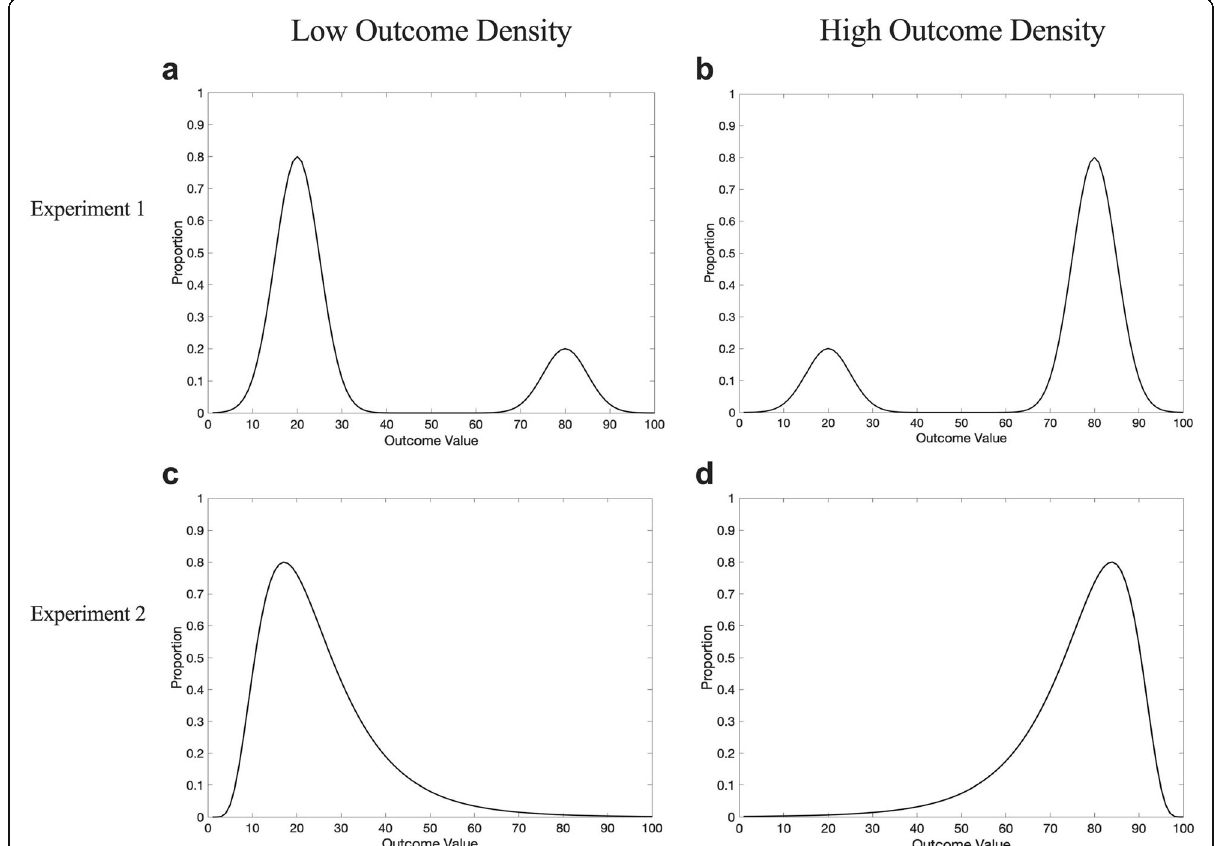
Fig. 1 a Bimodal outcome distribution presented to participants in variable outcome and low OD condition, where 80% of outcomes were low in magnitude. b Bimodal outcome distribution presented to participants in the variable outcome and high OD condition, where 80% of outcomes were high in magnitude. c Continuous outcome distribution presented to participants in the low OD condition, where 80% of outcomes were below an outcome value of 50. d Continuous outcome distribution presented to participants in the high OD condition, where 80% of outcomes were above an outcome value of